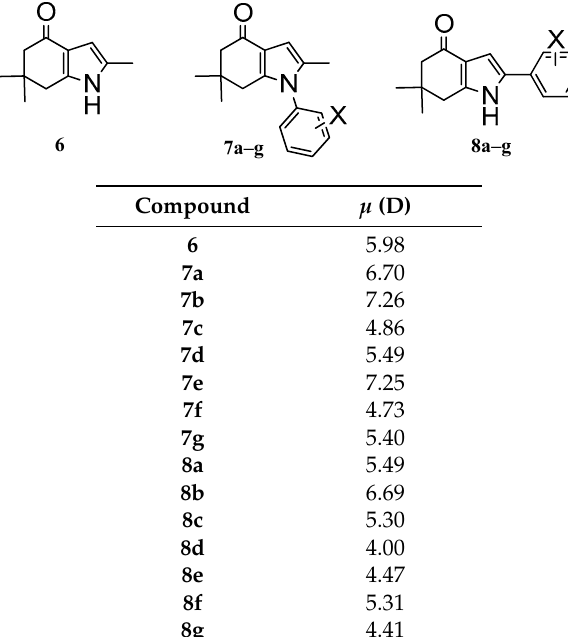
Table 7. Dipole Moment of indol-4-one; series I compounds 6 and 7a – g and series II compounds 8a – g .